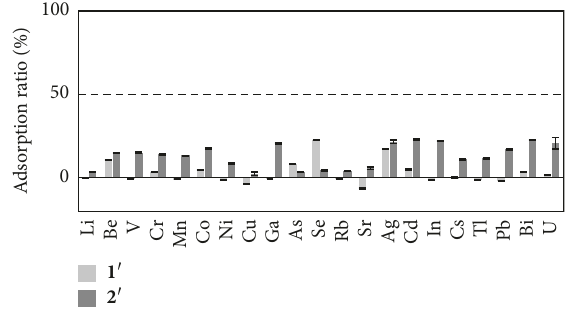
Figure 6: Metal adsorption from multielement solution C with hydrophilic gels 1